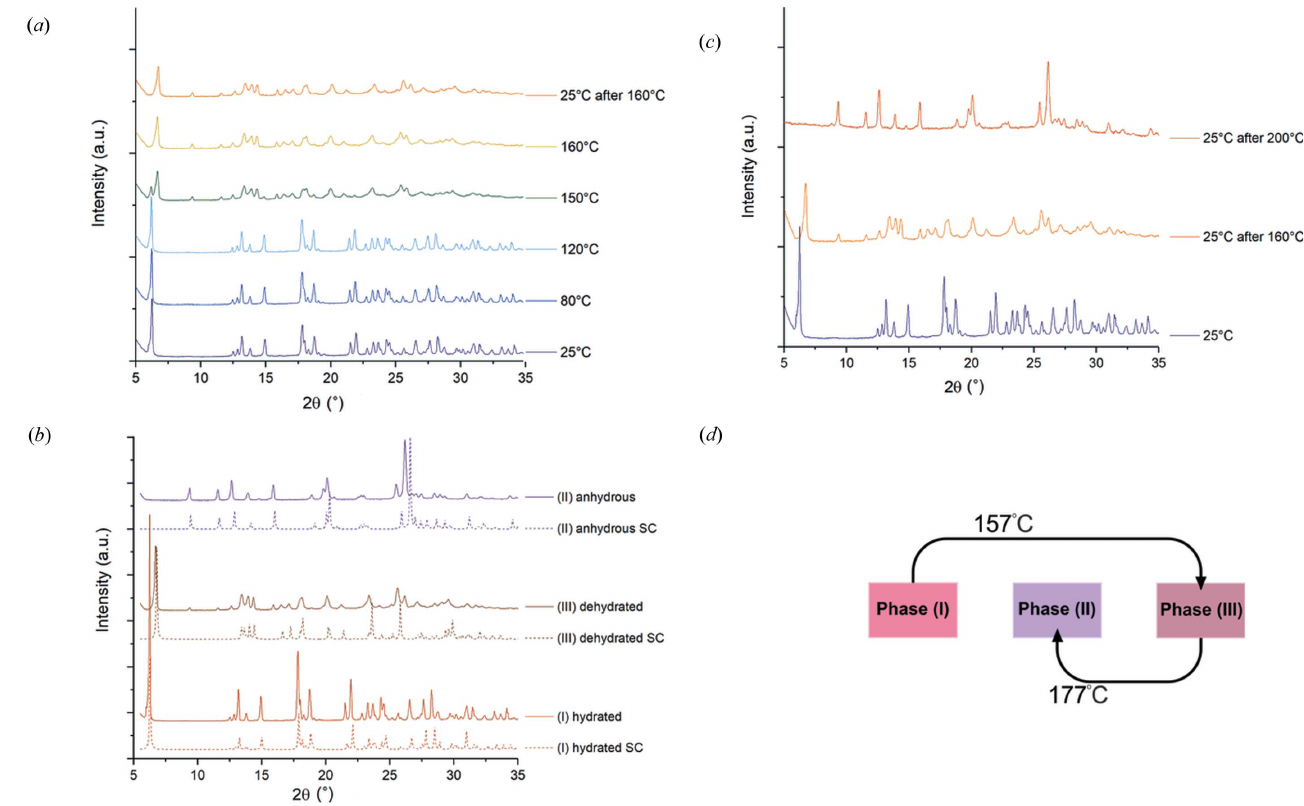
Figure 5 ( a ) Temperature evolution of (I) – phase transformation of (I) to (III) at ca 150 (cid:4) C. ( b ) X-ray powder diffraction patterns of (I), (II) and (III) (at room temperature), SC – simulated pattern from single-crystal X-ray diffraction. ( c ) Comparison between form (I) at 25 (cid:4) C, which was then transformed to (III) at 150 (cid:4) C and finally to (II a ) at ca 200 (cid:4) C. ( d ) Scheme of the phase transition between the